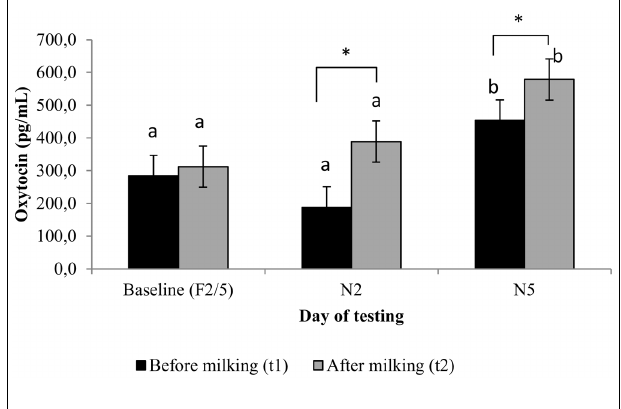
FIGURE 2 | Plasma oxytocin concentrations (pg/mL; least square means ± SEM ) of cows ( n = 20) before and after being milked in a familiar (Baseline) and novel milking environment (N2 and N5). ab Within sample collection time, least square means with